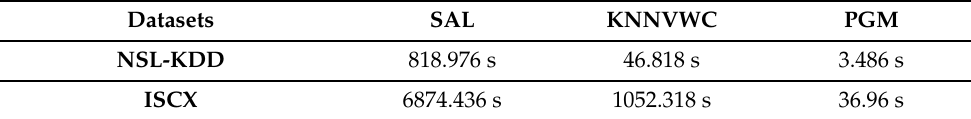
Table 5. Runtime comparison of the three semi-supervised